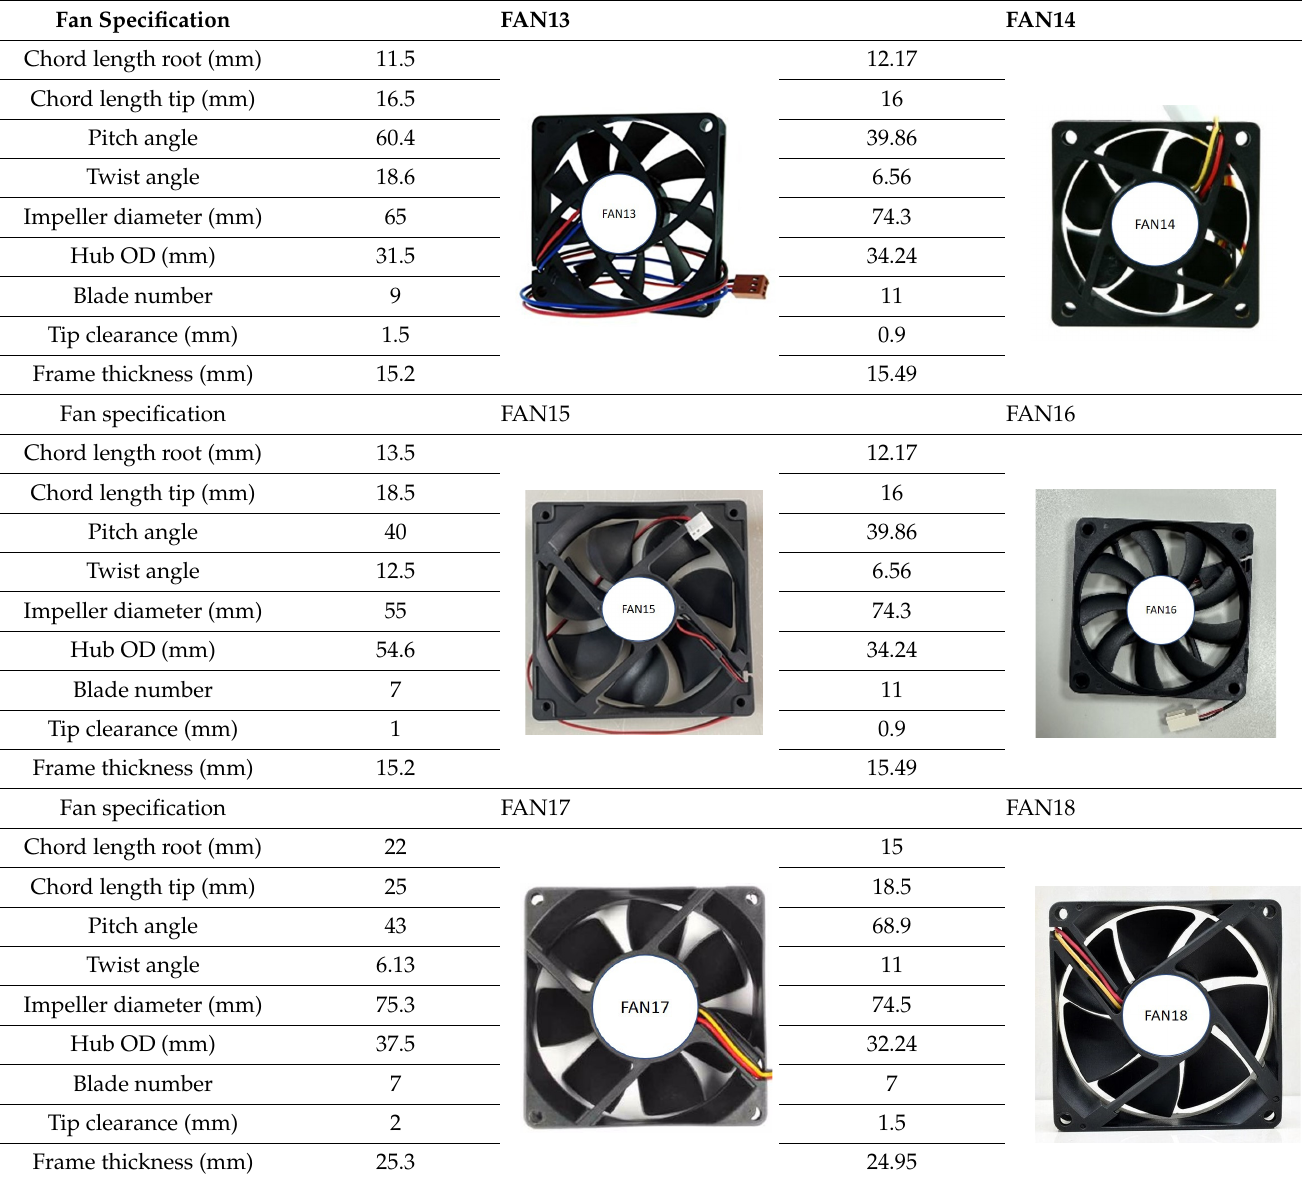
Table 4. Fan characteristics.